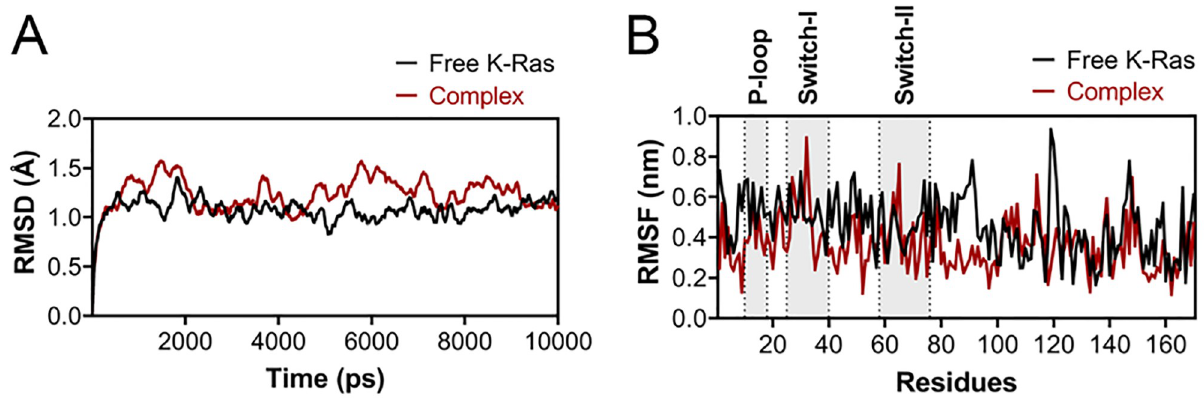
Fig 6. RMSD and RMSF plots of free K-Ras and Kras-peptide complex. ( A ) The RMSD and ( B ) RMSF of plots of free (black) and complex (red) K-Ras forms after a 10 ns MD simulation. The position of target domains is shown the B panel.